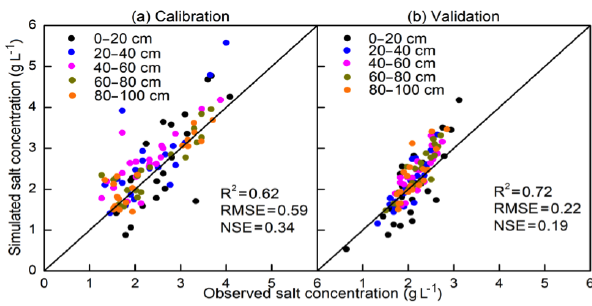
Figure 16. Comparison of predicted and observed salt concentra- tion during calibration (a) and validation (b)